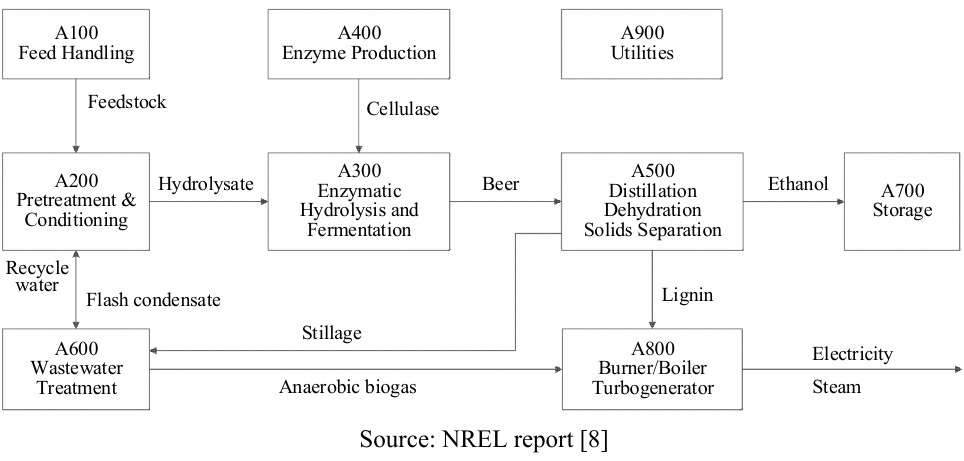
Figure 1. Simplified flow diagram of the overall